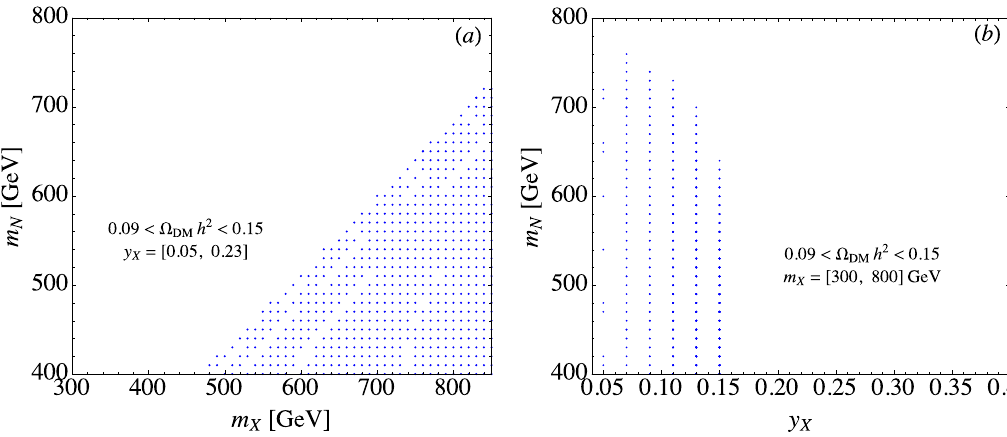
Figure 6 . Legend is the same as in (cid:12)gure 3, but for the m (cid:31)